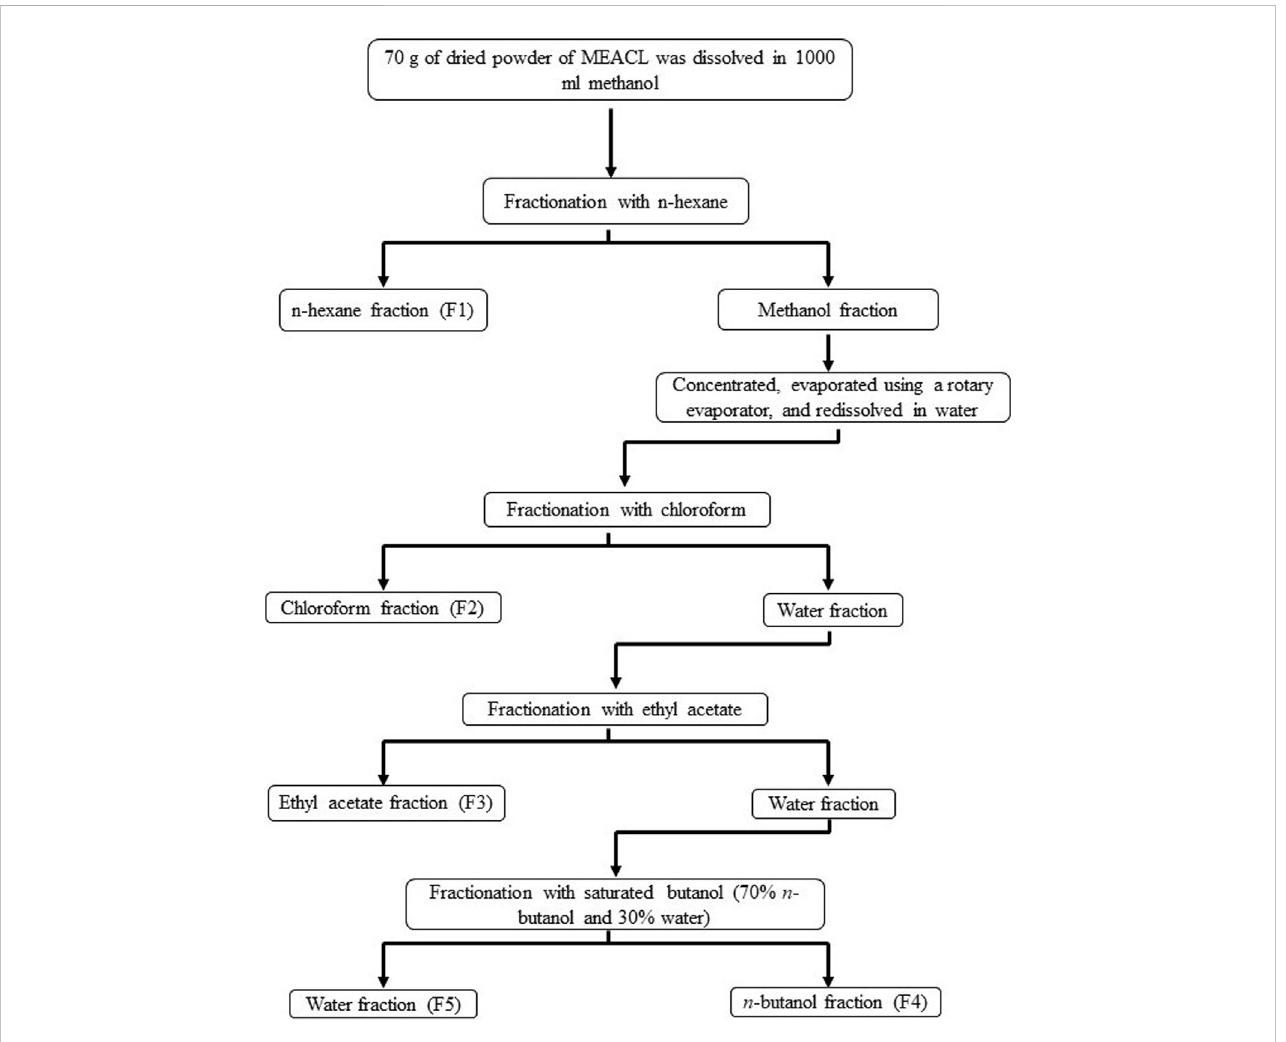
FIGURE 1 A fl ow chart showing the fractionation of